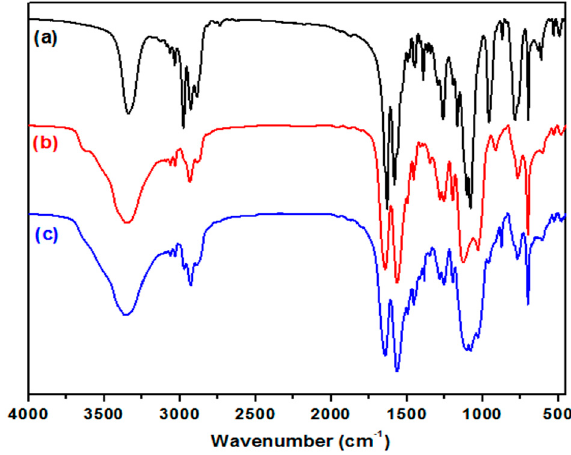
Figure 10. ( a ) Solid-state 29 Si CP-MAS NMR spectroscopy of chiral PMO NPs and ( b ) solid state 13 C CP-MAS NMR spectroscopy of chiral PMO NPs.